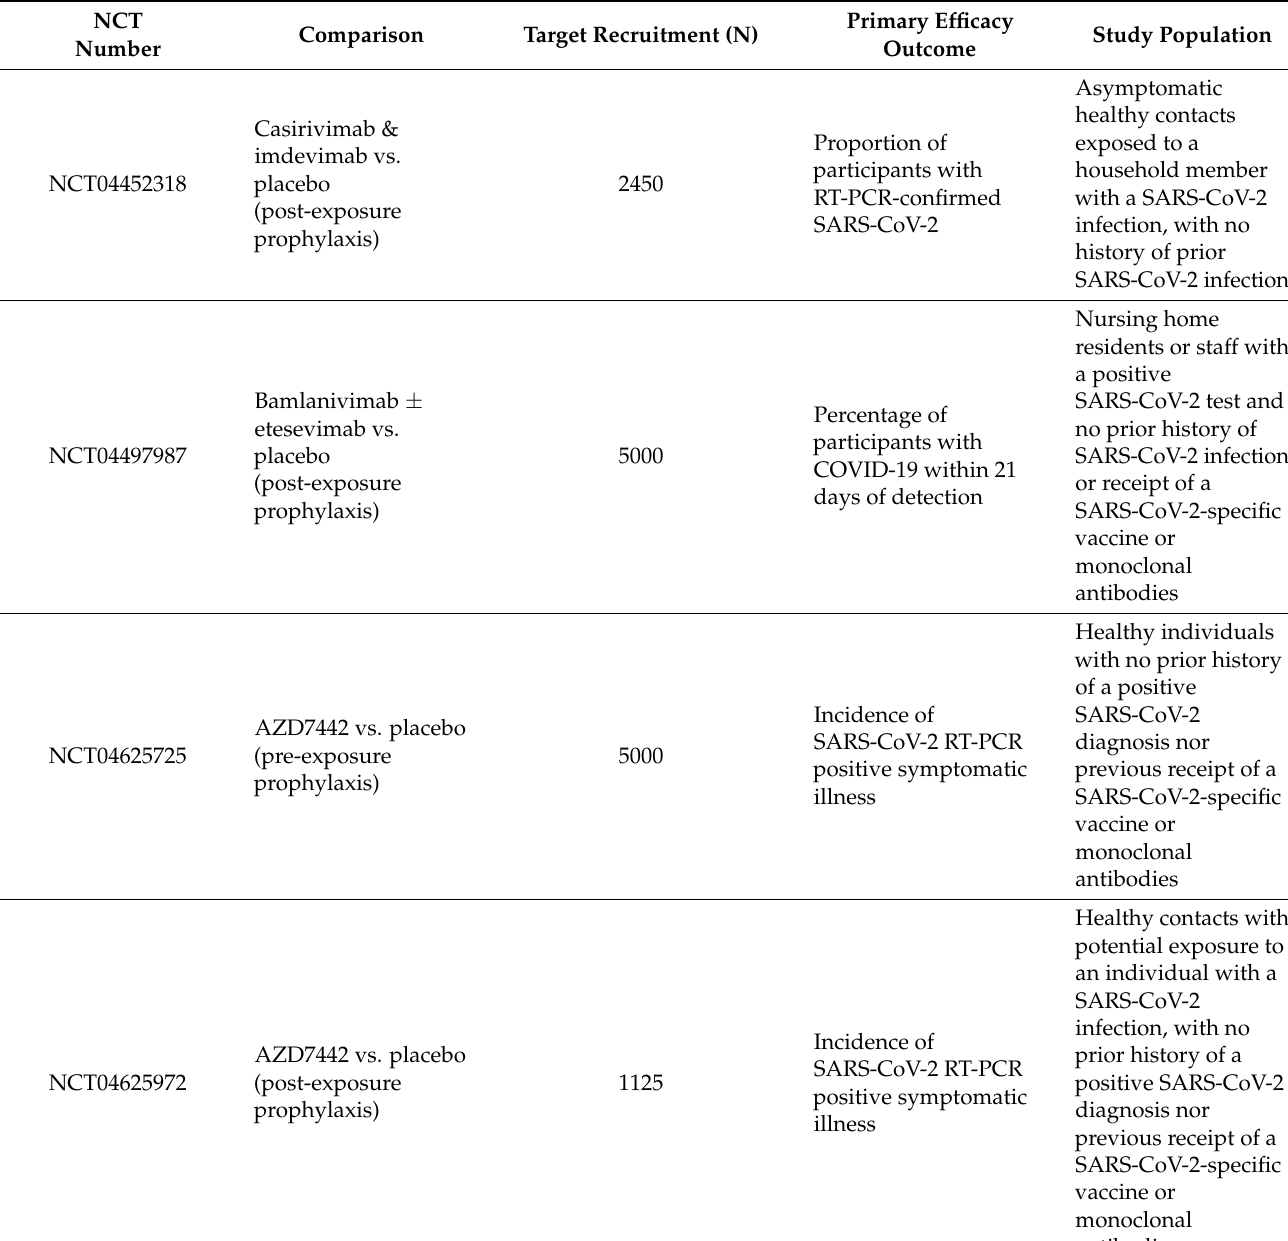
Table 2. Overview of Ongoing Phase 3 Prophylaxis